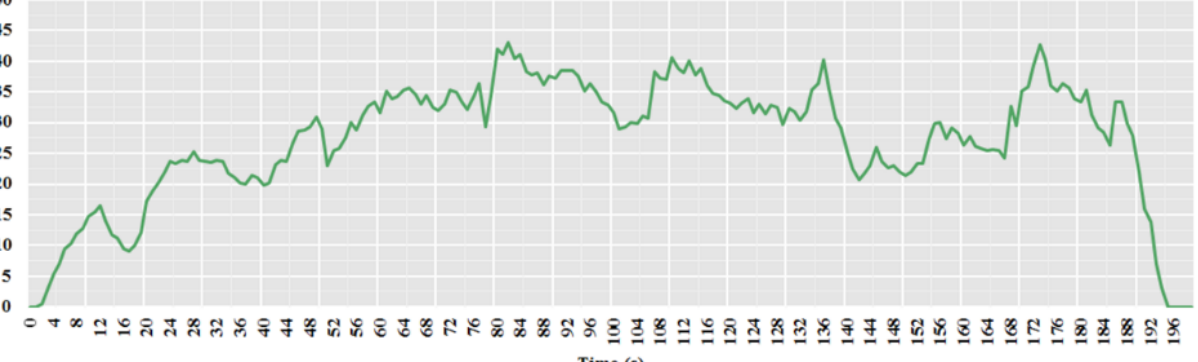
Figure 14. A section of driving condition data was randomly selected from the validation database.